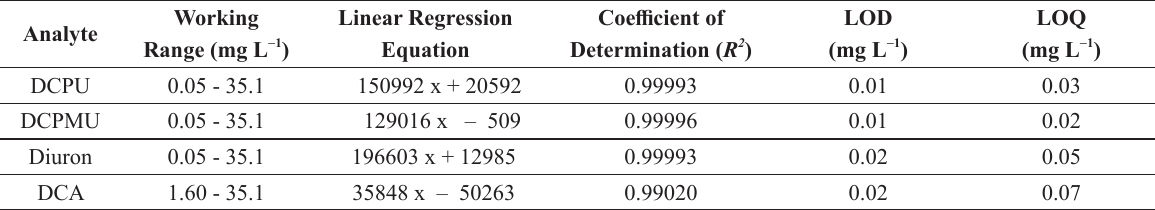
Parameters of linear regression, limits of detection (Lod) and quantitation (LoQ) for diuron and the metabolites (n=3).